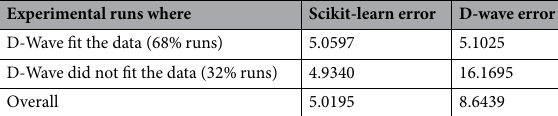
Table 1. Comparing regression error.